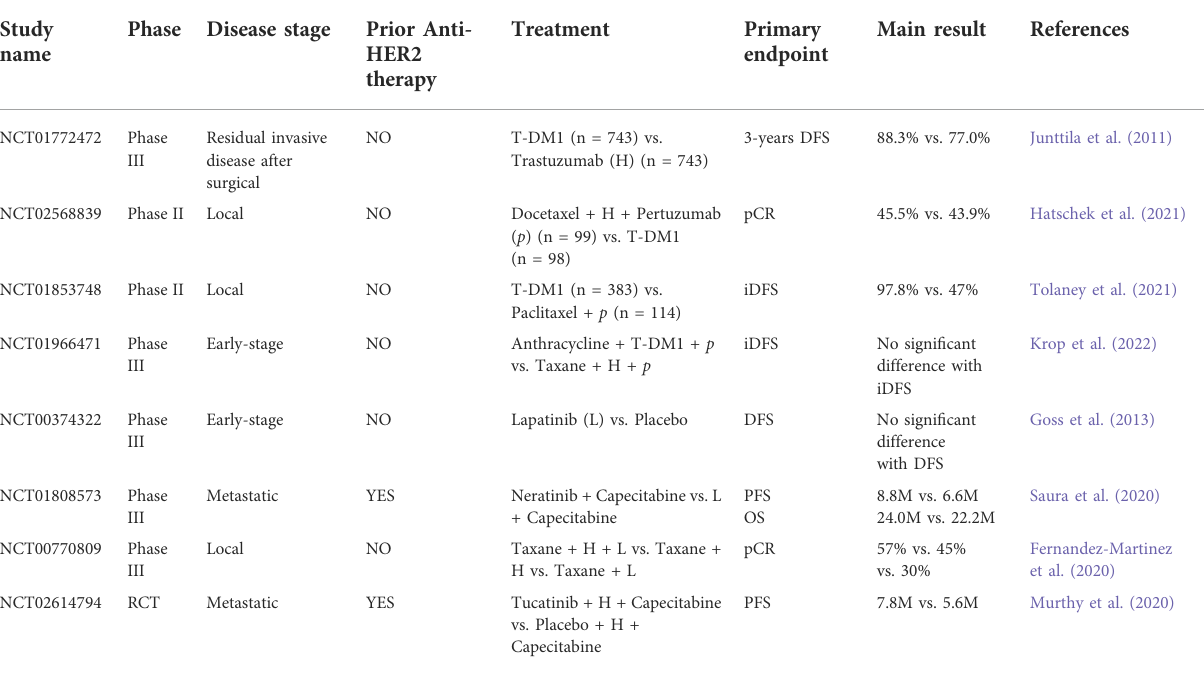
TABLE 1 Clinical trials of anti-HER2